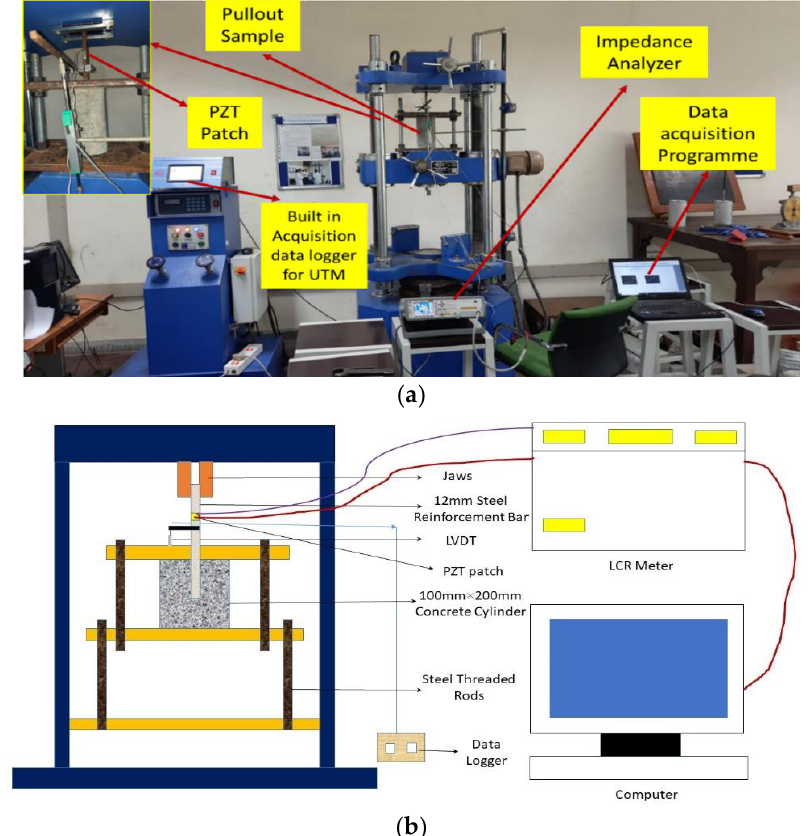
Figure 3. ( a ) The experimental setup for bond strength monitoring ( b ) Schematic diagram.